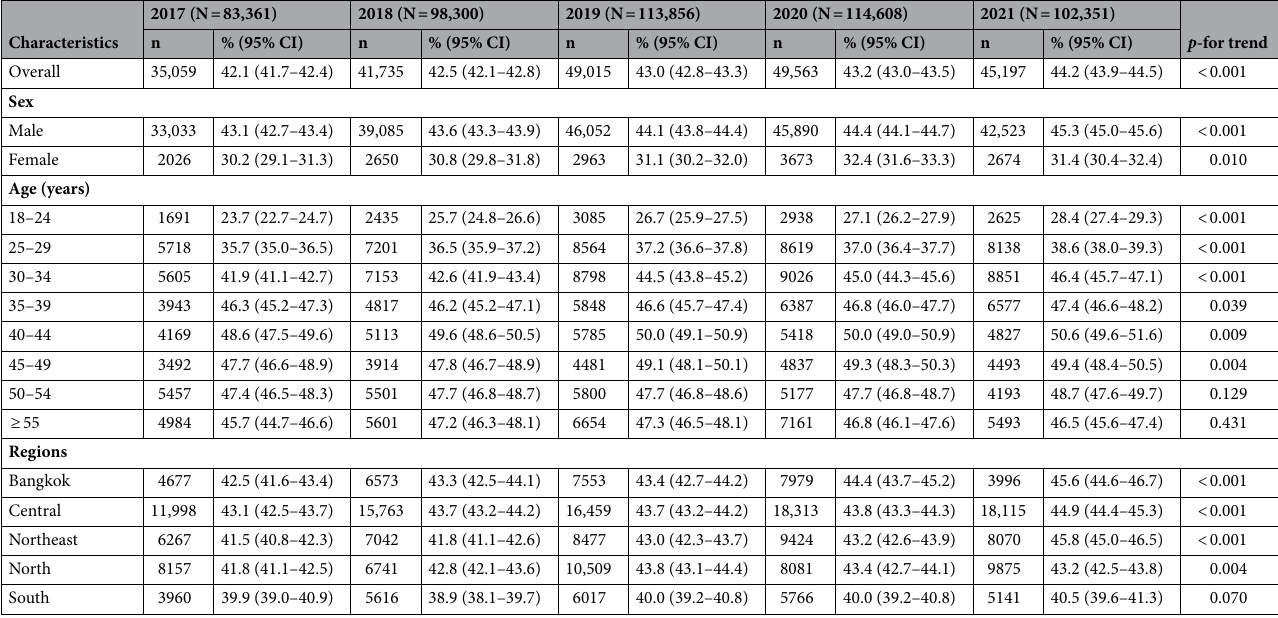
Table 2. Trends in obesity prevalence (BMI ≥ 25 kg/m 2 ) among RTA personnel from 2017 to